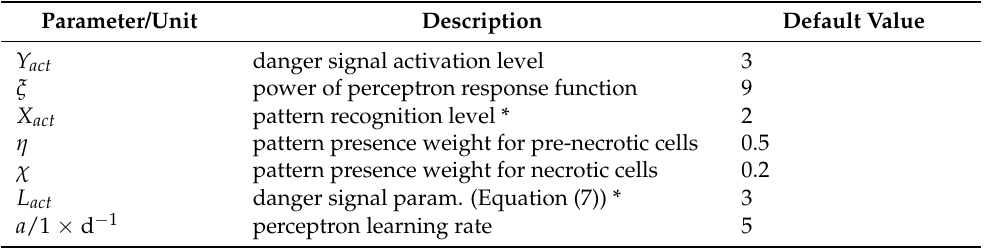
Table 2. Model parameters for pattern-recognition: parameters used for the investigated scenario; parameters considered as susceptible for hyperthermia are indicated by an asterisk.